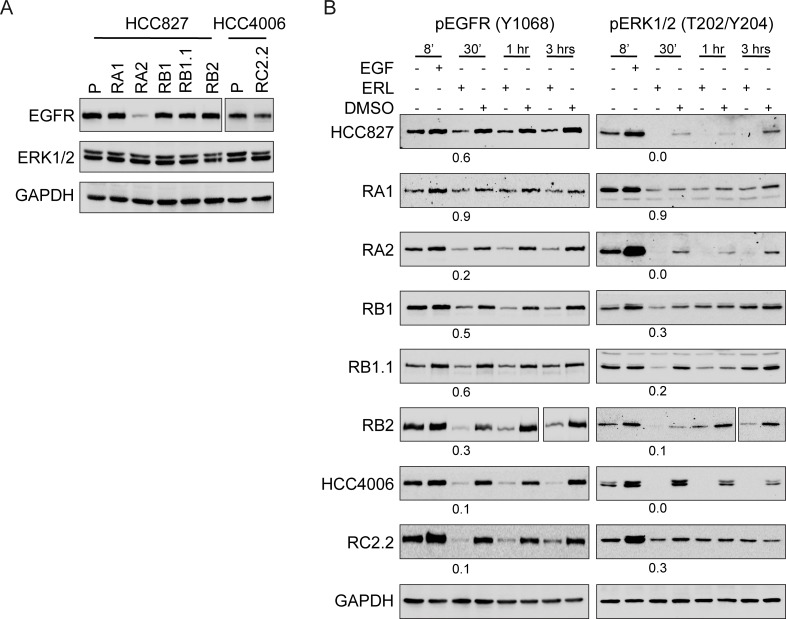
Erlotinib impairs EGFR and ERK1/2 phosphorylation in ERL-resistant cell lines.A) Representative western blots with EGFR and ERK1/2 antibodies and B) pEGFR (Y1068) and pERK1/2 (T202/Y204) antibodies in the indicated parental and ERL-resistant cell lines treated with EGF (100 μg/ml), ERL (Erlotinib, 100 nM) or vehicle (DMSO) at different time points (8’, 30’, 1hr, 3hrs). Densitometric analyses of band signals were normalized with GAPDH, the number indicates the signals quantification at 30’ upon ERL-treatment. For RA2 cell line double amount of total cell lysate was loaded to analyze EGFR expression.